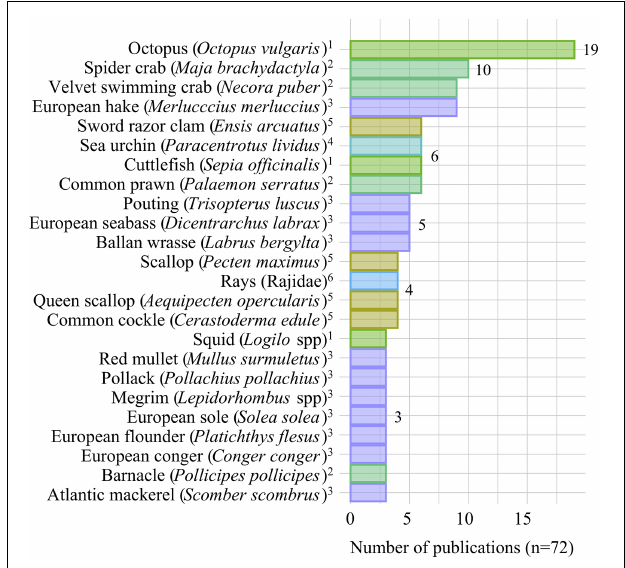
FIGURE 7 | Species studied in the analyzed publications. Subindexes (and colors according to Figure 6 ): 1 Cephalopod, 2 Crustacean, 3 Fish, 4 Echinoderm, 5 Bivalve, and 6 Elasmobranch. Only the species recorded in more than three publications are shown (24 of 96 total